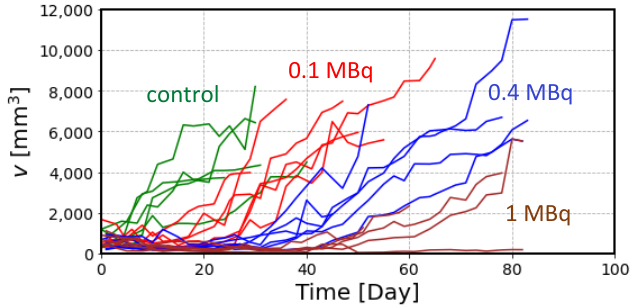
Figure 3. Experimental data of tumor volume in each mouse obtained from the previous experiment with 211 At treatment [7]. Each polygonal line represents the measured tumor volume in each mouse classified into 4 groups according to the administered dose: control (green), 0.1 MBq (red), 0.4 MBq (blue) and 1 MBq (brown).